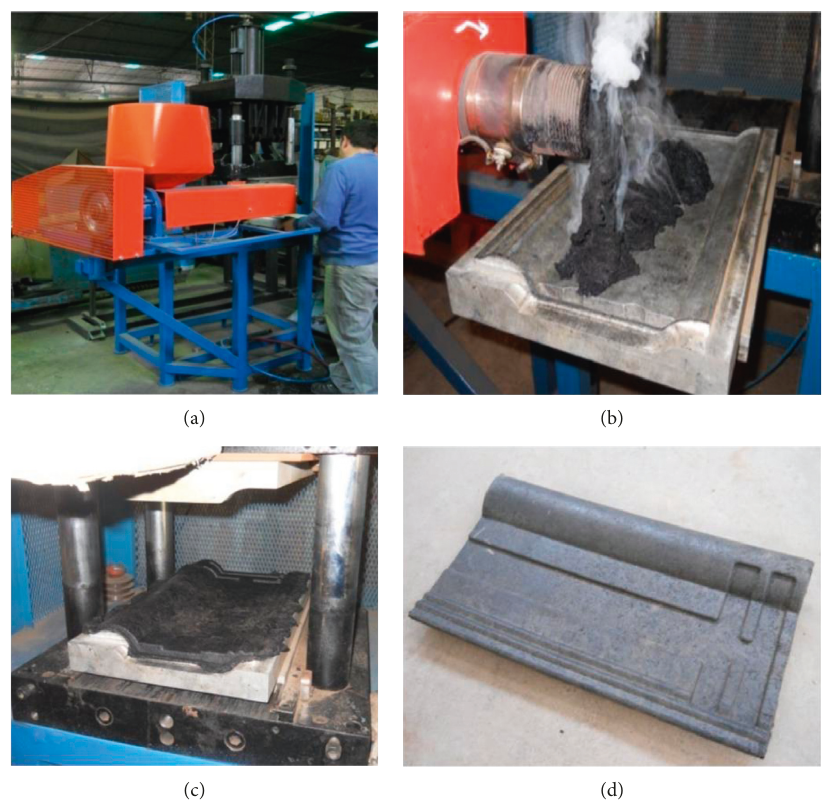
Figure 6: Extruder and pressing machine (a), filling the mold with the mixture (b), thermomolding of the component (c), and finished roofing tile